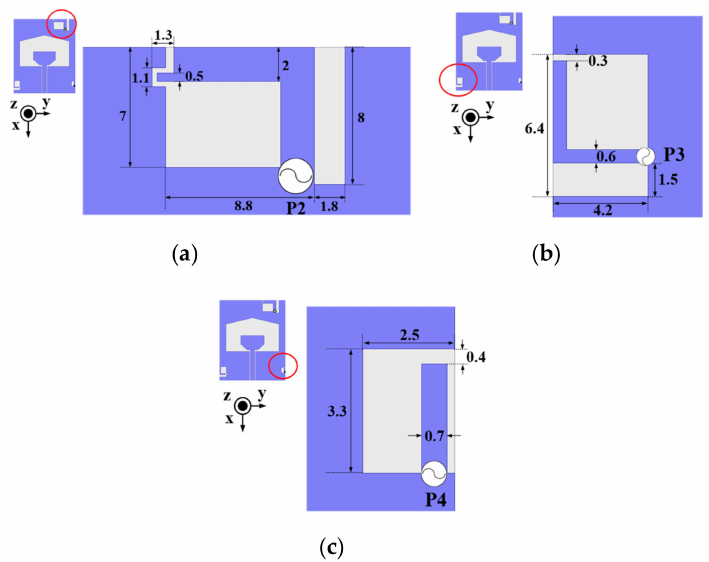
Figure 1. Geometry of the proposed antenna: ( a ) top view ( b ) side view (all dimensions are in mm). NB: narrowband; UWB: ultra-wideband.